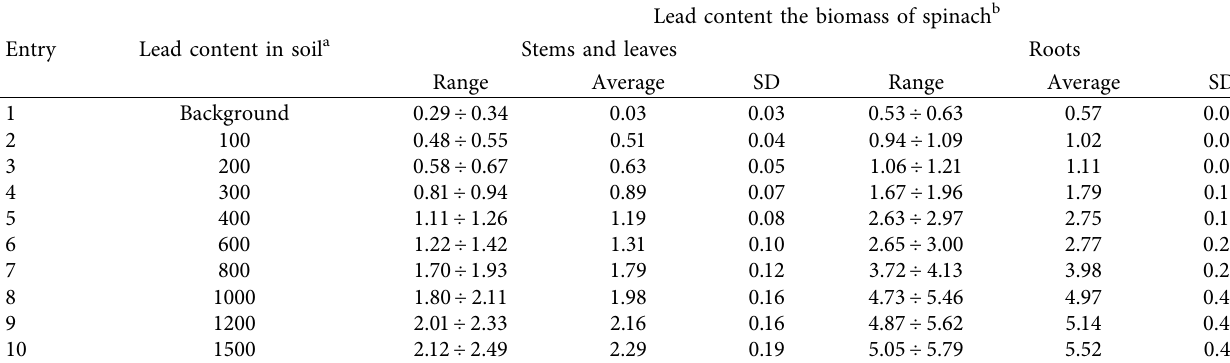
Table 3: Concentration of lead in this metal-contaminated soil and in the biomass of spinach grown in this soil. Entry Lead content in soil a